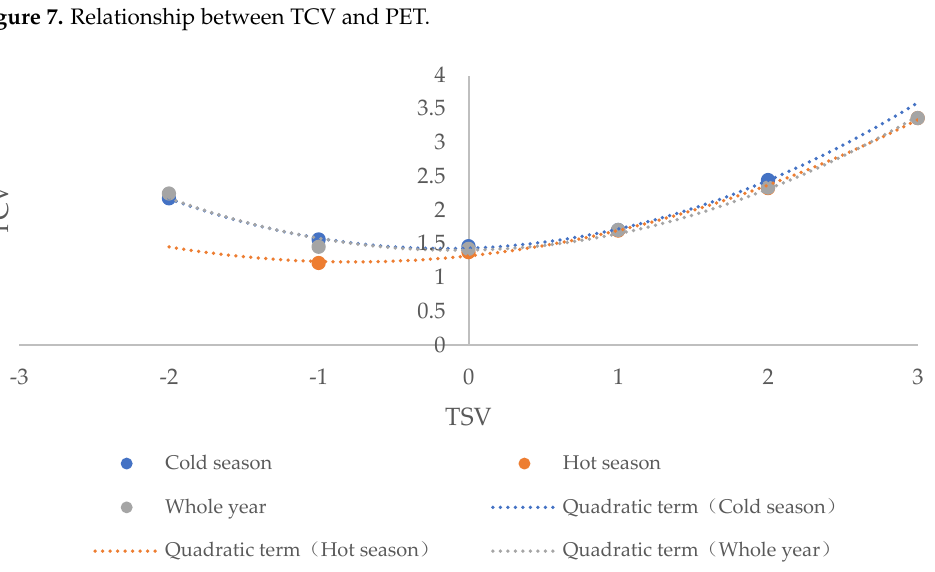
Figure 8. Relationship between TSV and TCV .